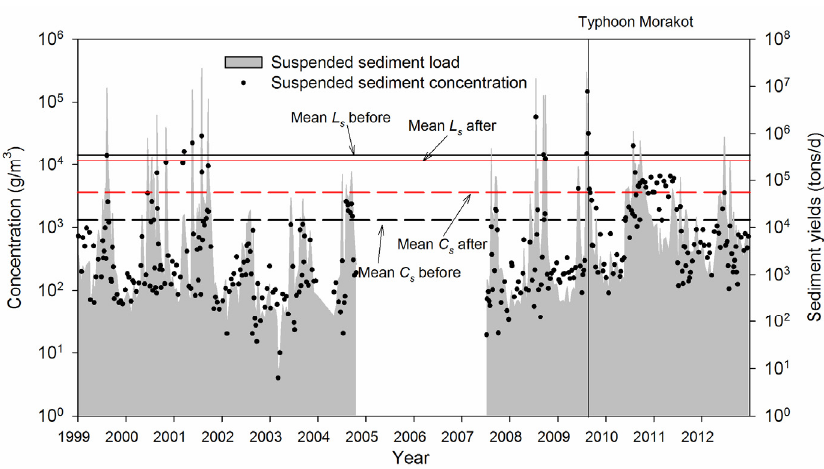
Figure 8. Observed suspended sediment concentrations and loads in Liling Bridge from 1999 to 2012. Measurements interrupted during October 2004 to May 2007 due to reconstruction